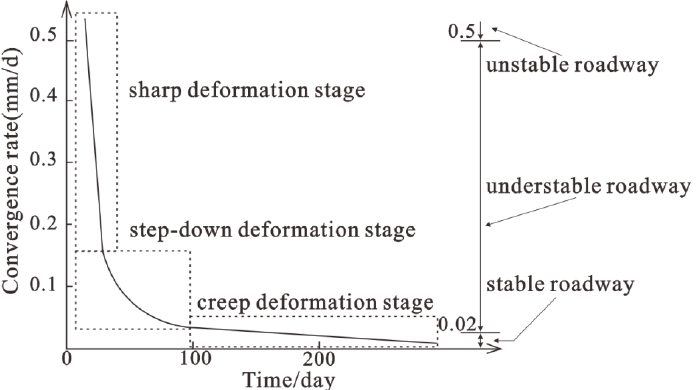
Figure 7. A typical convergence rate–time curve of studied roadways.